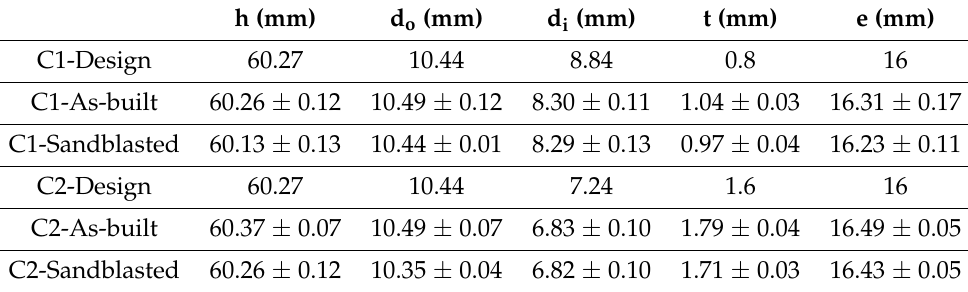
Table 4. Dimensions of C1 and C2 by design, as-built and